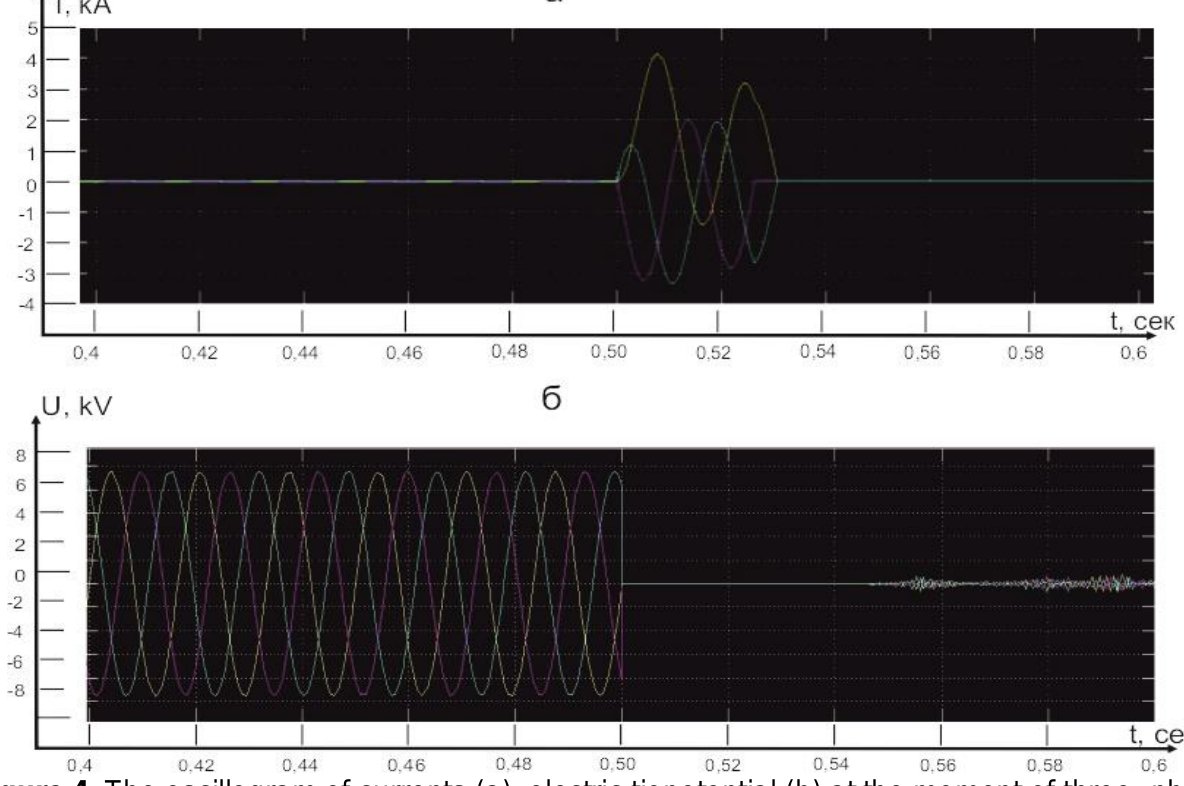
Figure 4. The oscillogram of currents (a), electric tiopotential (b) at the moment of three -phase fault on the oscillogram marked three main time line (figure 4 a, b). а) from 0 sec. – to 0.5 sec typical operation network b) from 0.5 sec. – to 0.53 sec operating emergency period from instant fault inception